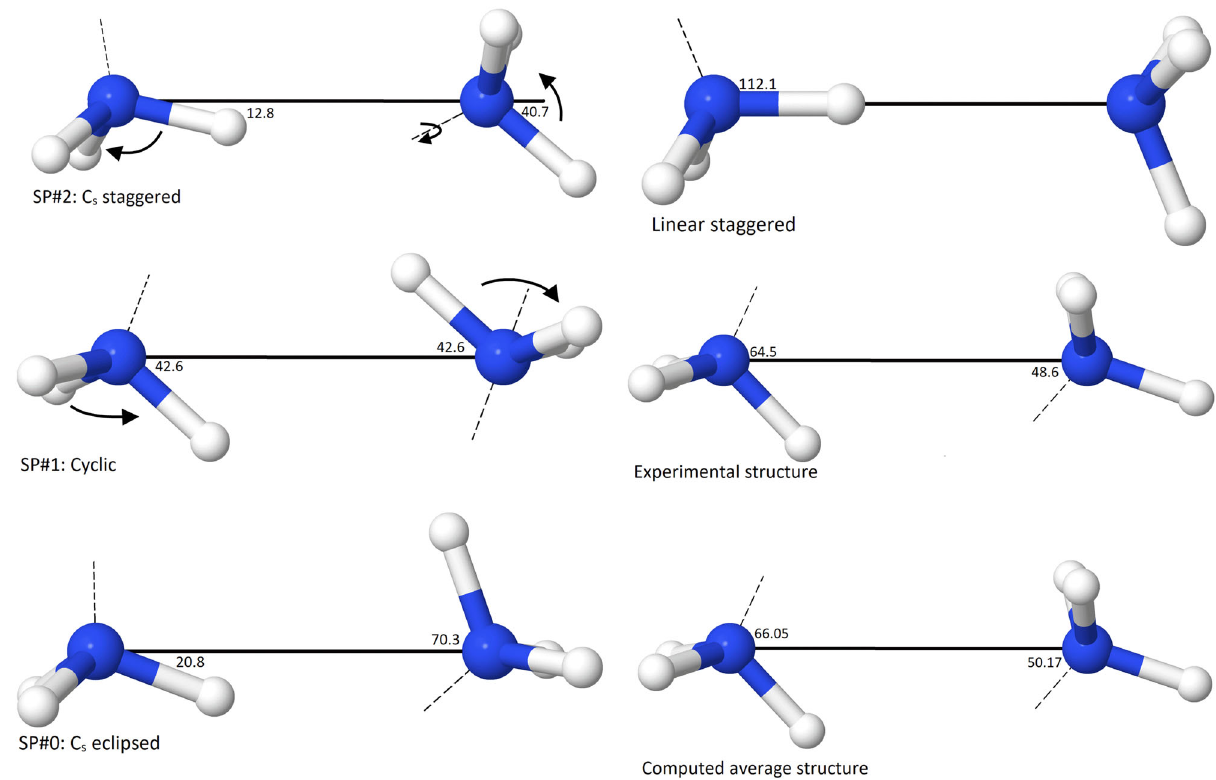
Fig. 1 Structures of the ammonia dimer. Left column: stationary points. Right column: the linear hydrogen-bonded structure predicted by the 1980s theory 6 , the experimental structure 7 – 9 , and the average structure from the present work. In the left column, the numbers are ∠ HNN angles in degrees, except for SP#2 monomer B, where 180- ∠ HNN is listed. In the right column, the angles shown for the experimental and the average structures are between the C 3 axes of monomers and the principal rotational axis of the complex. For the linear structure, the C 3 -NH angle is shown. The arrows visualize the motions on the paths from SP#1 and SP#2 to